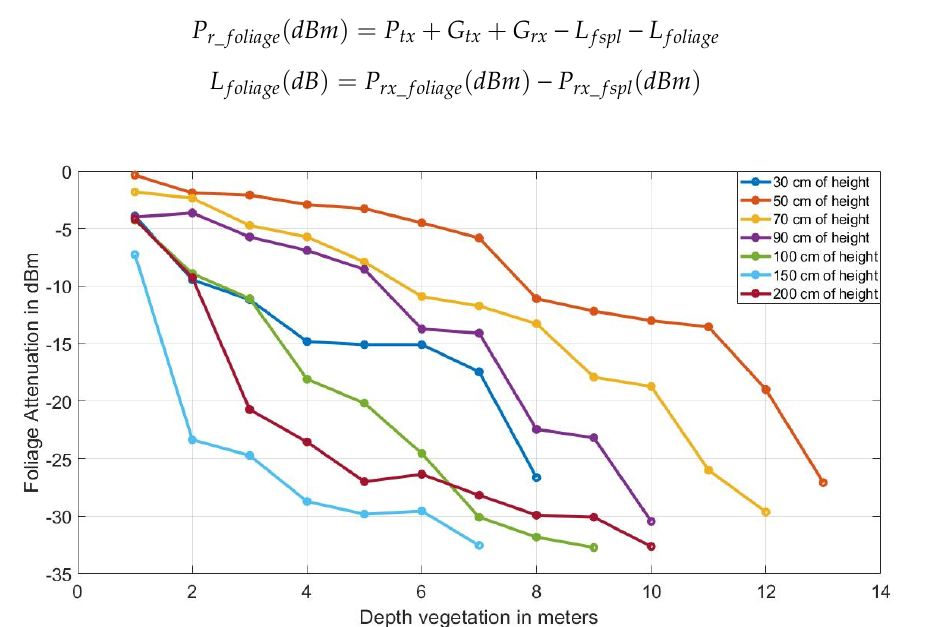
Figure 6. Attenuation average in (dB) of the four locations by foliage presence between transmitter (Tx) and receiver (Rx) nodes at different heights from the ground (30 cm, 50 cm, 70 cm, 90 cm, 100 cm, 150 cm).